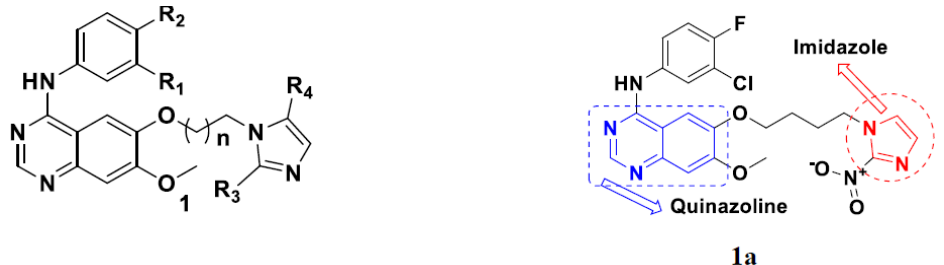
Figure 2. Structure of quinazoline-based imidazole hybrids and the most promising compound 1a . Table 1. In vitro cytotoxic activities of hybrid compounds 1 ( b – e ).